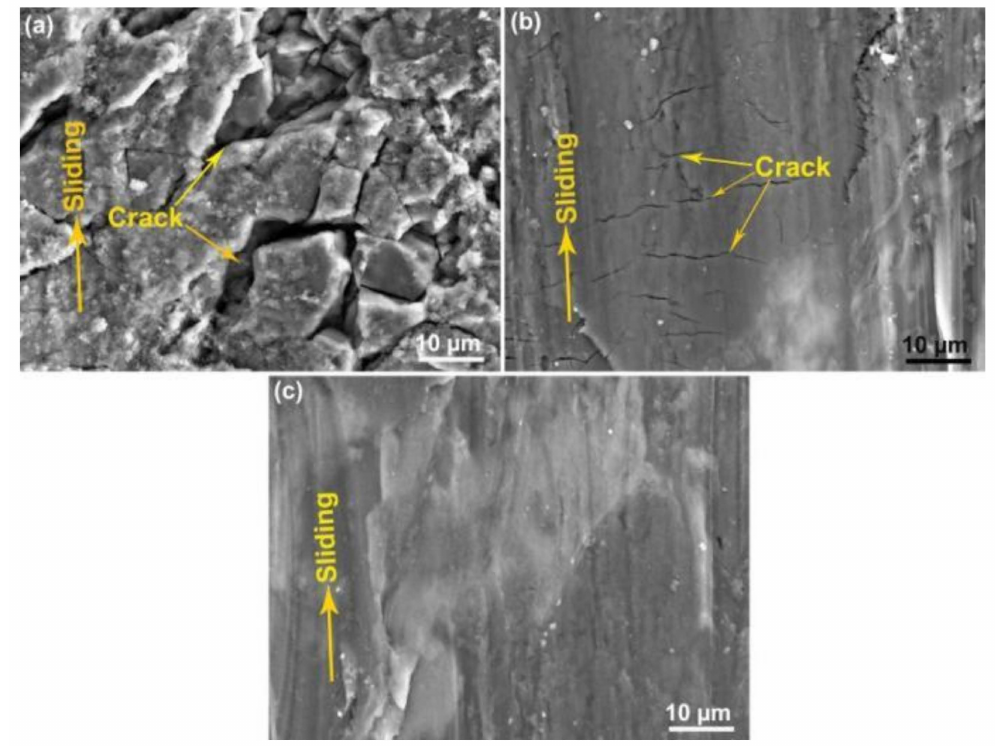
Figure 8. SEM wear track images of all fabricated materials: ( a ) M0, ( b ) M1, ( c ) M2.